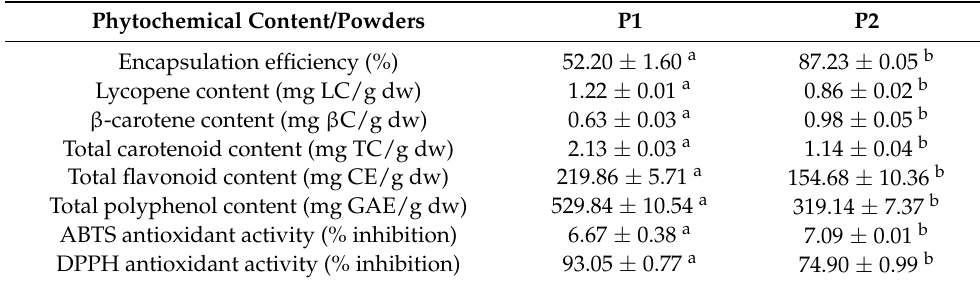
Table 3. Phytochemical profile of the powders obtained by the microencapsulation of the sea buckthorn extracts.